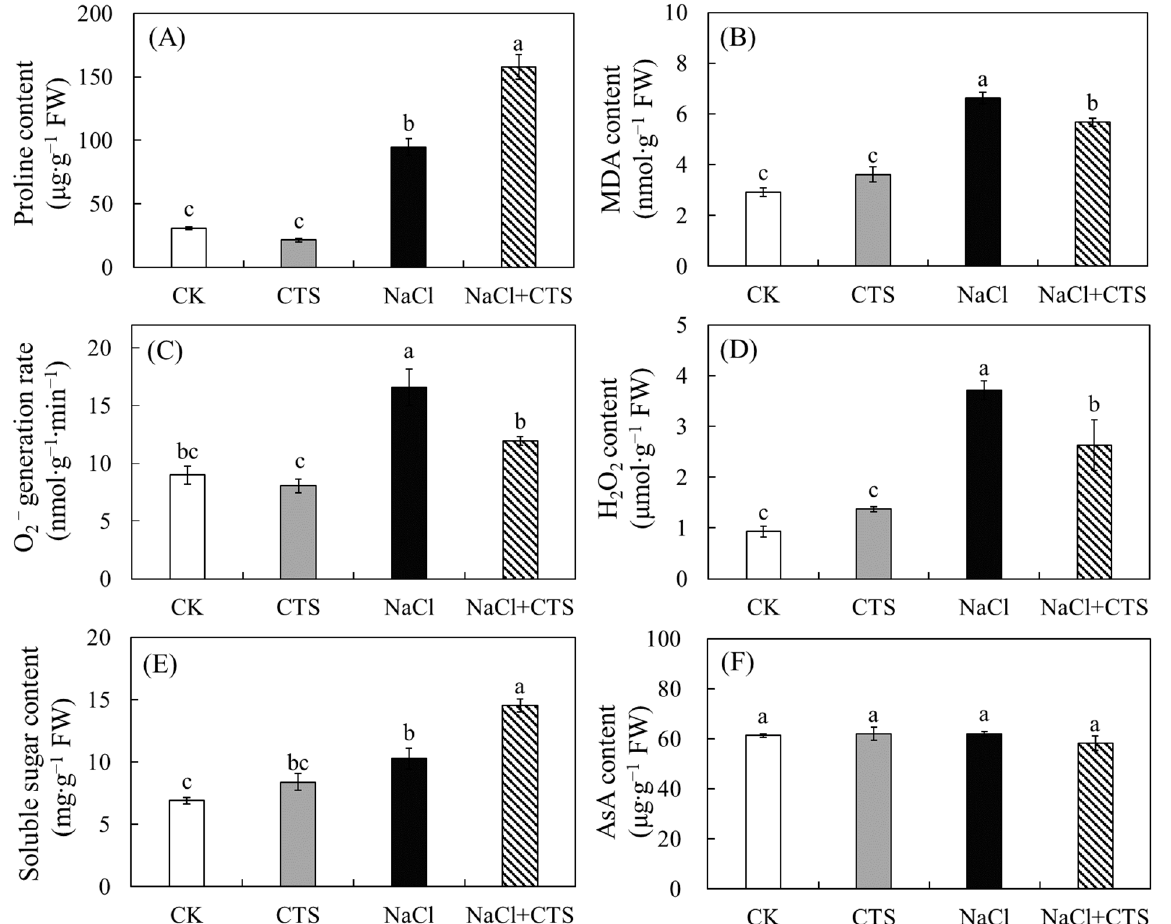
Figure 3. Effects of exogenous chitosan (CTS) on ( A ) proline content, ( B ) MDA content, ( C ) O 2 − generation rate, ( D ) H 2 O 2 content, ( E ) soluble sugar content, and ( F ) AsA content in leaves of lettuce plants under salt stress. Data presented are the means ± SEs ( n =3). Different letters on top of bars indicate a significant difference ( p < 0.05) according to Tukey’s HSD test. CK (control) = 0 mM NaCl + 0 mg/L CTS; CTS = 0 mM NaCl + 100 mg/L CTS; NaCl = 100 mM NaCl + 0 mg/L CTS; NaCl + CTS = 100 mM NaCl +100 mg/L. MDA, malondialdehyde; O 2 − , superoxide radical; H 2 O 2 , hydrogen peroxide; AsA, ascorbic acid.